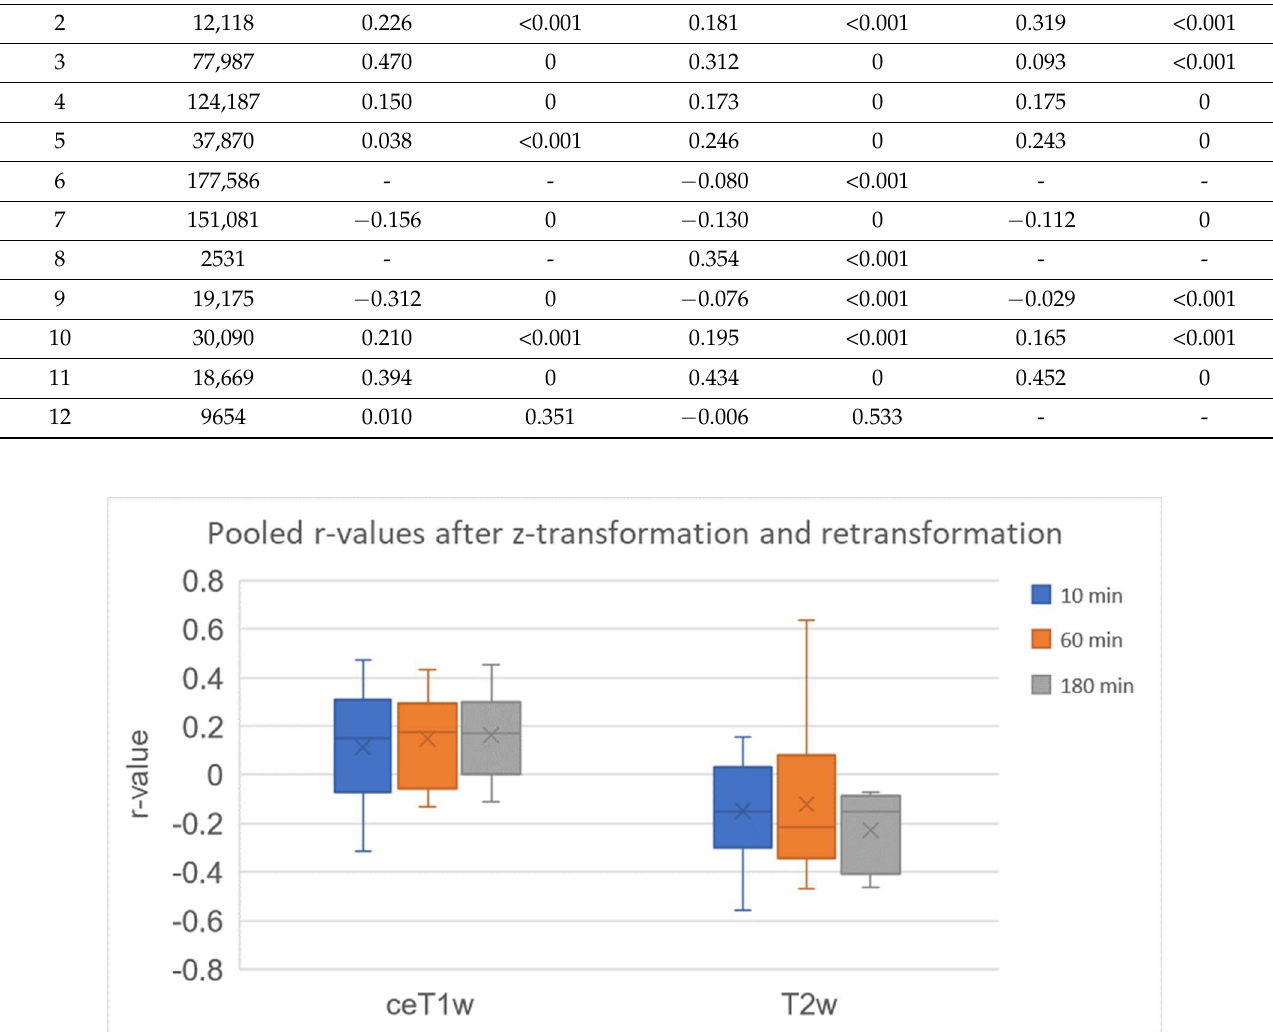
Figure 1. Pooled r-values of the correlation between 68 Ga-FAPI PET and MRI sequences (contrast enhanced T1w and T2w) after z-transformation and retransformation at all three timepoints. Range of pooled r-values (ceT1w): 10 min ( − 0.312 to 0.470), 60 min ( − 0.130 to 0.434) and 180 min ( − 0.112 to 0.452). Range of pooled r-values (T2w): 10 min ( − 0.559 to 0.156), 60 min ( − 0.466 to 0.637) and 180 min ( − 0.462 to − Table 3. Correlation results of 68Ga-FAPI uptake and ceT1w MRI signal.